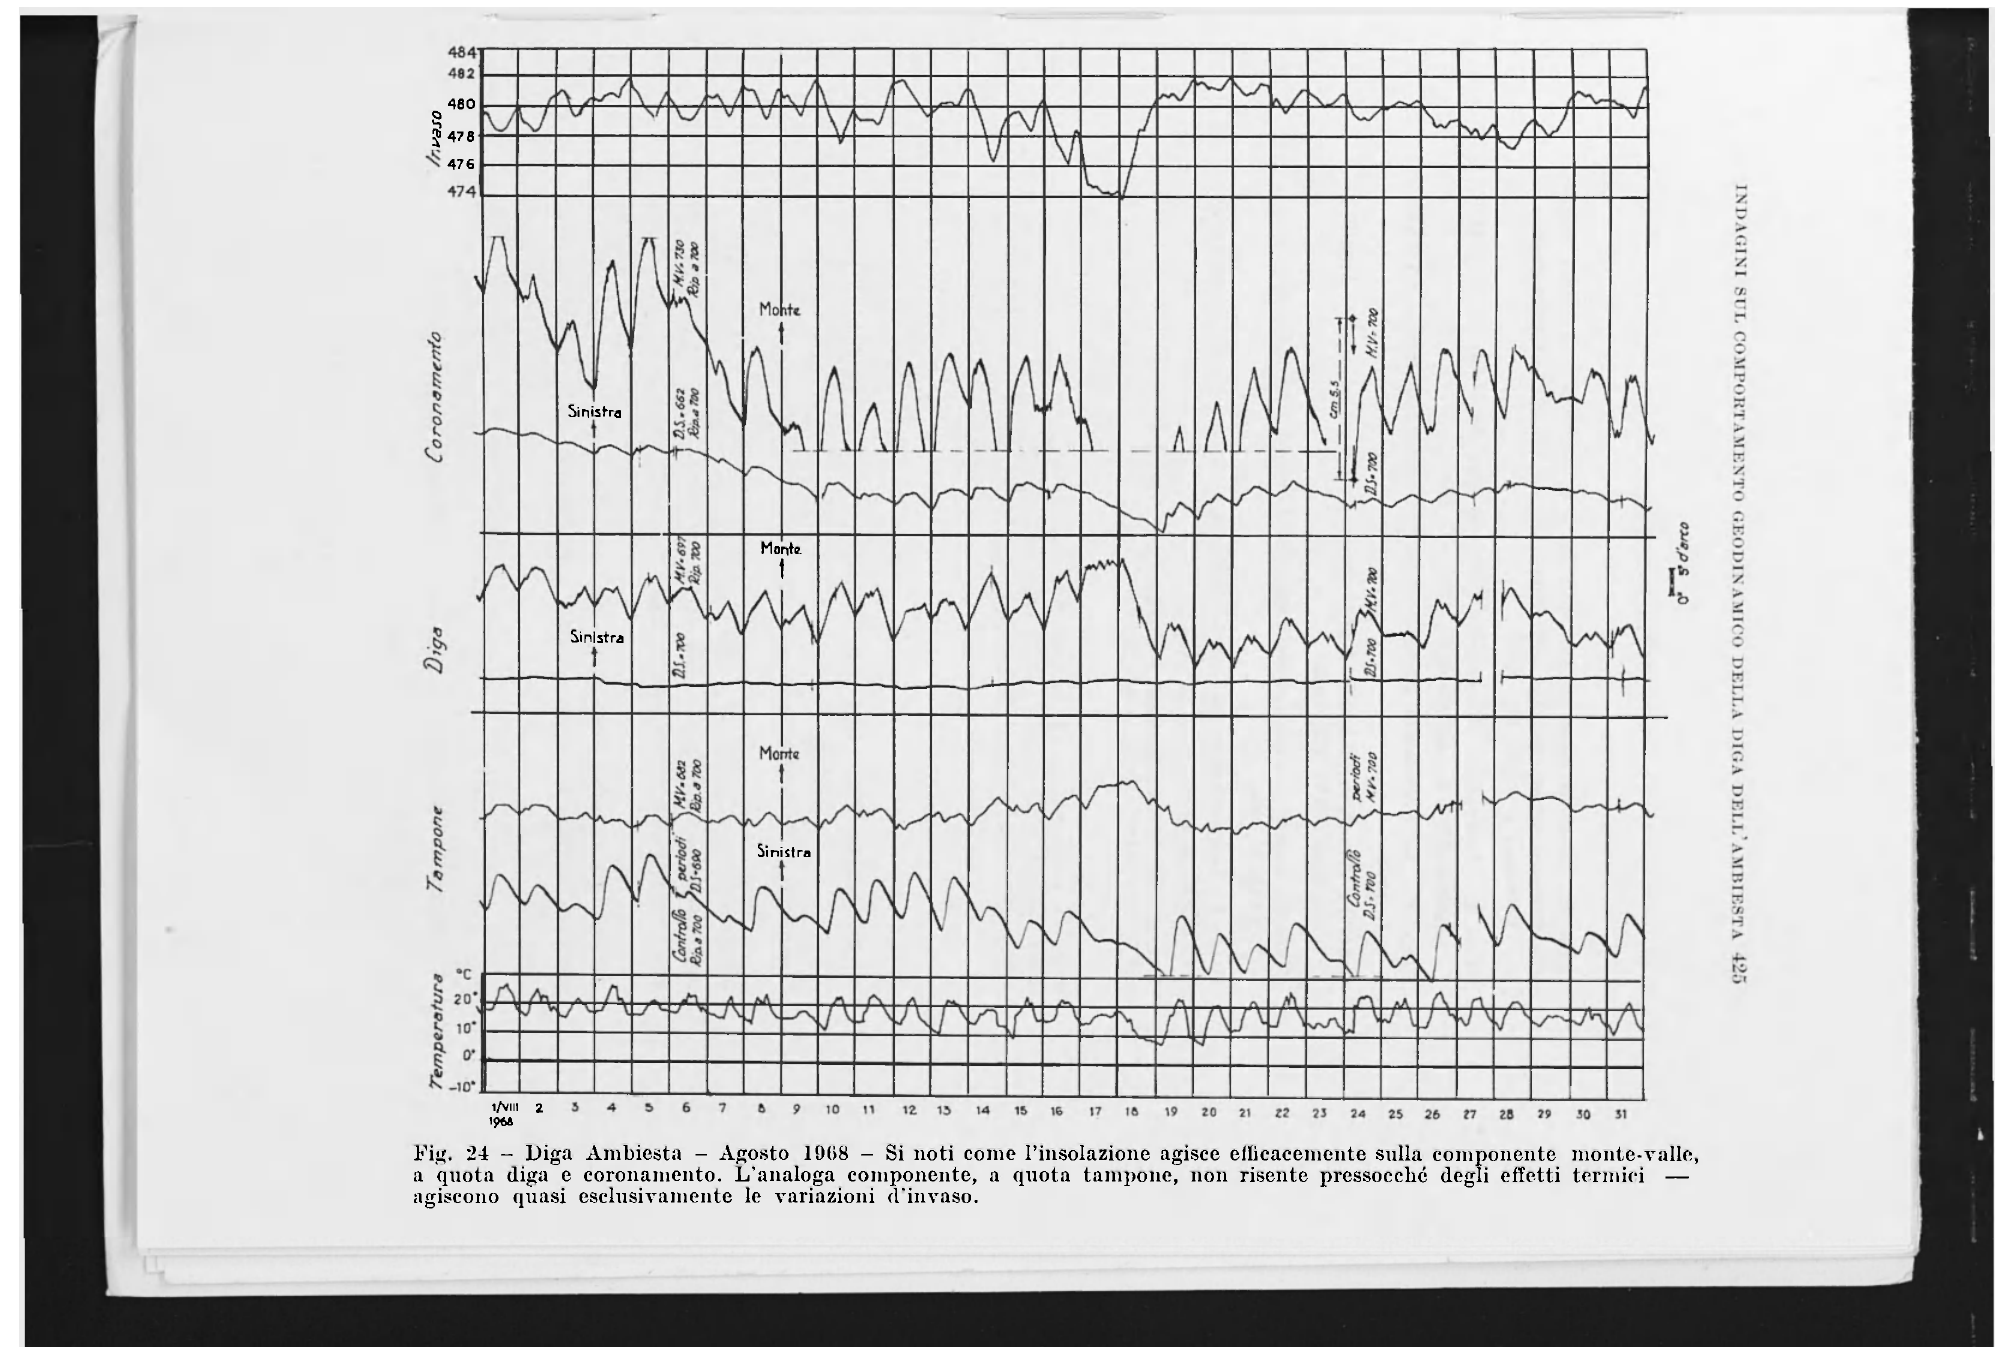
Fig. 24 - Diga Ambiesta - Agosto 1968 - Si noti come l'insolazione agisce efficacemente sulla componente monte-valle, a quota diga e coronamento. L'analoga componente, a quota tampone, non risente pressocché degli effetti termici — agiscono quasi esclusivamente le variazioni